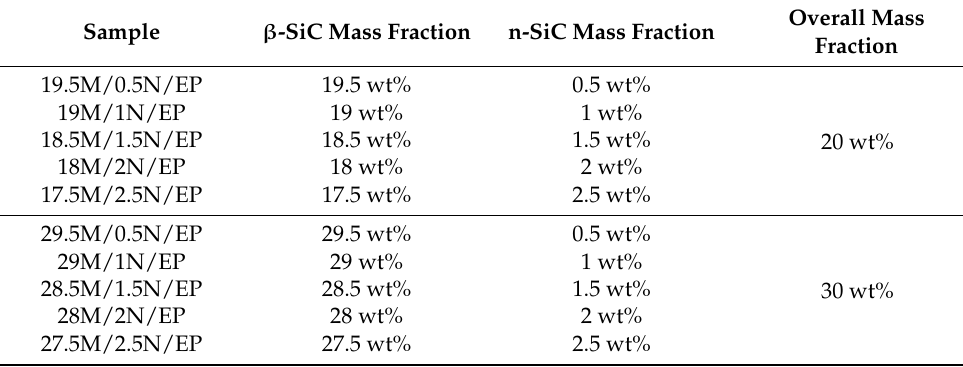
Table 3. SiC/EP composites filled with micro/nano particles.